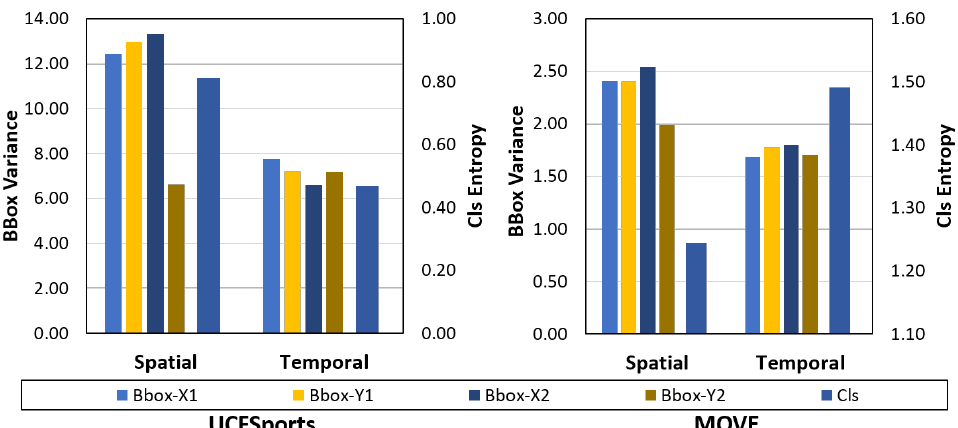
Figure 15. Left: Spatial and Temporal Uncertainty for class and location variables on the UCFSports dataset; Right: On the MOVE dataset.